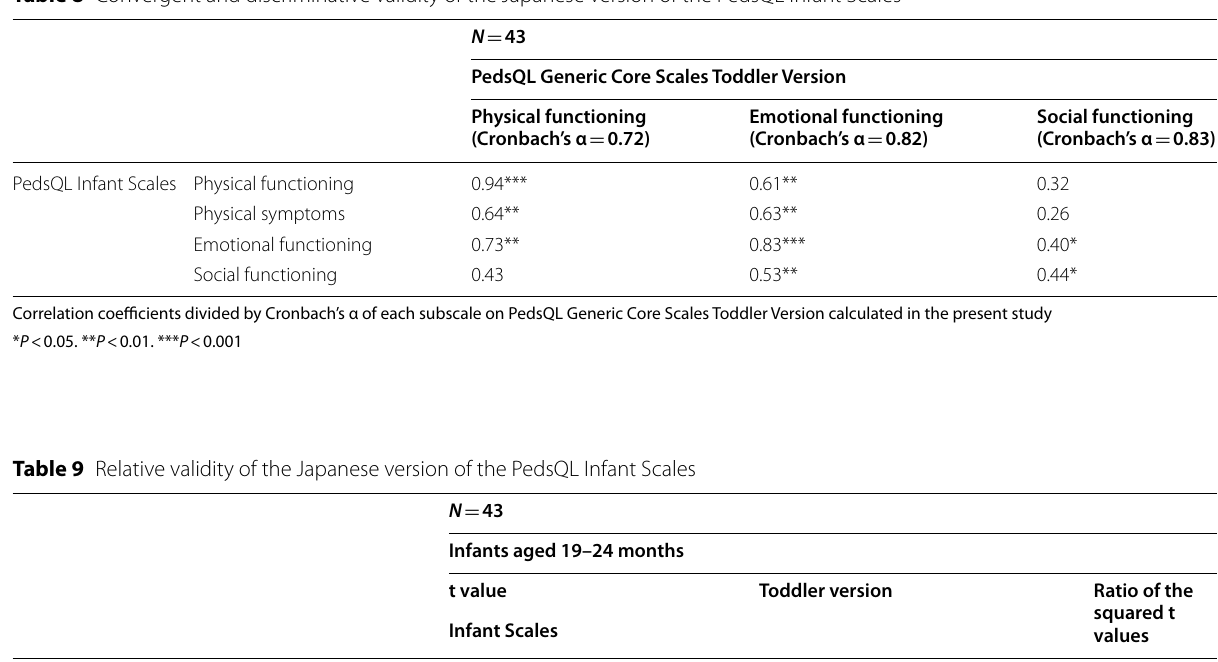
Pearson’s product–moment correlation coefficients to assess that Physical Health Summary, Psychosocial Health Summary, and the total score on PedsQL Infant Scales were positively correlated with the same scale scores on PedsQL Generic Core Scales ** P < 0.01 Table 8 Convergent and discriminative validity of the Japanese version of the PedsQL Infant Scales